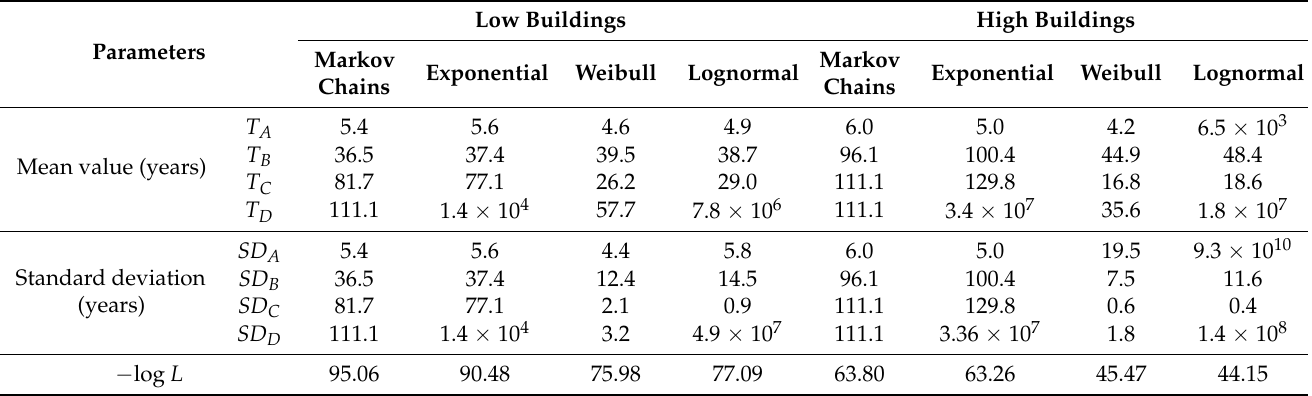
Table 2. Comparison of the optimal parameters obtained for Markov chains and Petri net (exponential, Weibull, and lognormal) for low and high